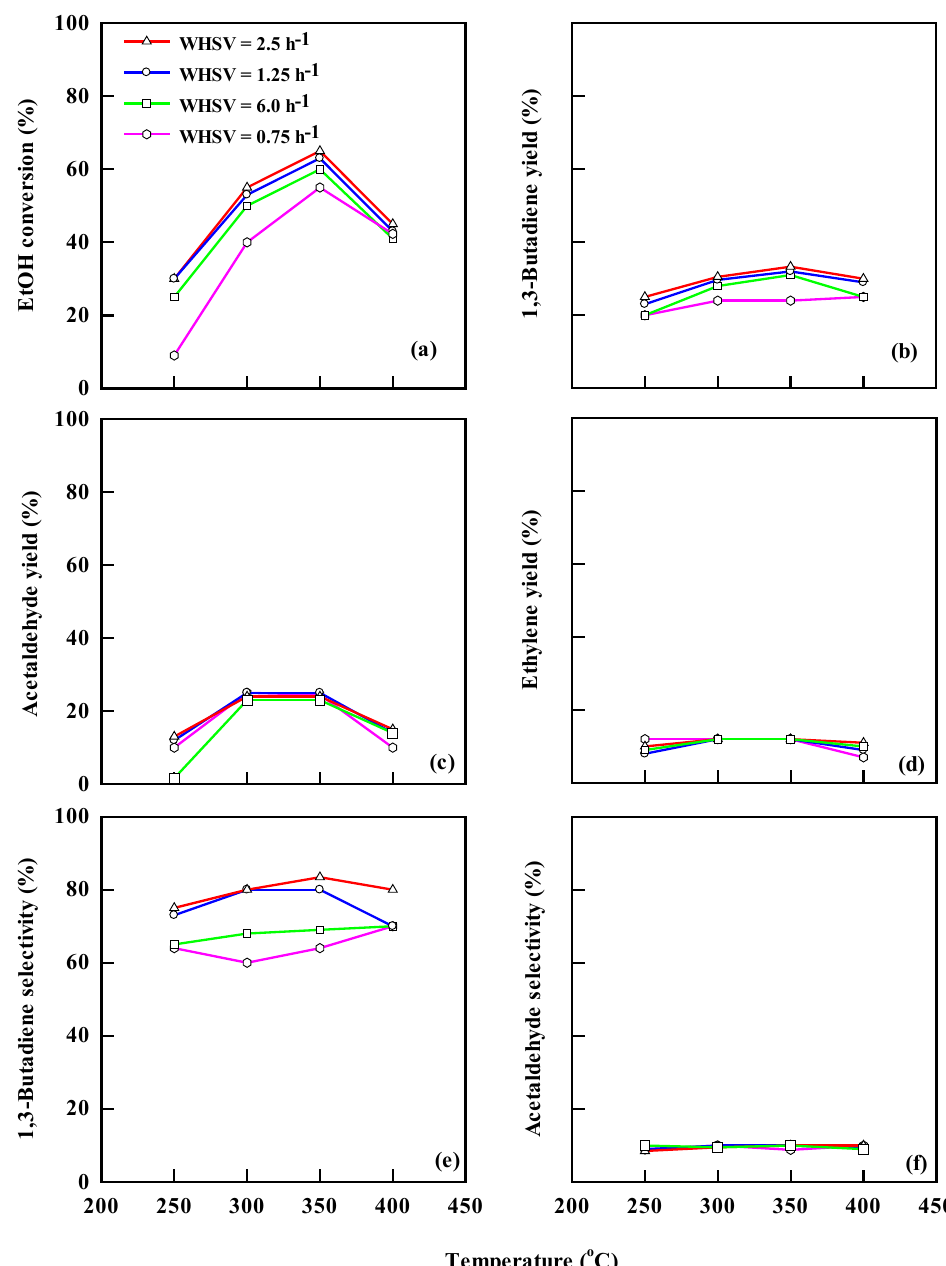
Figure 8. Plot of ( a ) ethanol conversion, ( b ) yield of 1,3-butaiene ( c ) acetaldehyde yield ( d ) ethylene yield ( e ) 1,3-butadiene selectivity and ( f ) acetaldehyde selectivity at different reaction temperatures and WHSV using Ash:MgO (1:3) catalyst. Catalyst: 0.4 g, WHSV = 0.75–6.0 h −1 , N 2 : 30 mL/min.